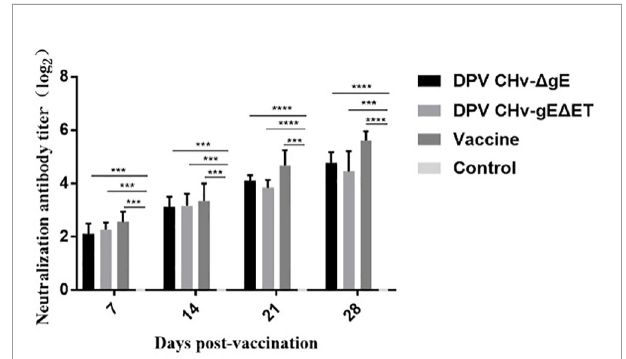
FIGURE 8 | The determination of neutralizing antibody titer in ducks of different groups after immunization. *** P < 0.001, **** P < 0.0001.